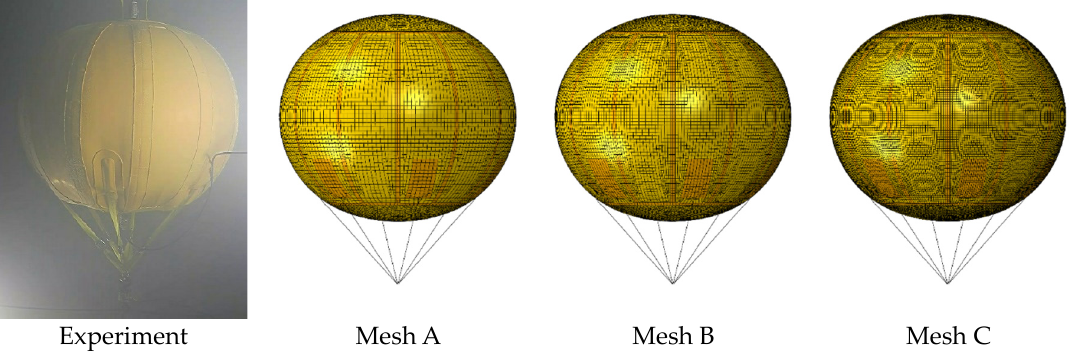
Figure 7. Full- fi lled airbag con fi guration in the experiment and di ff erent meshes with three element Figure 7. Full-filled airbag configuration in the experiment and different meshes with three element sizes. sizes.